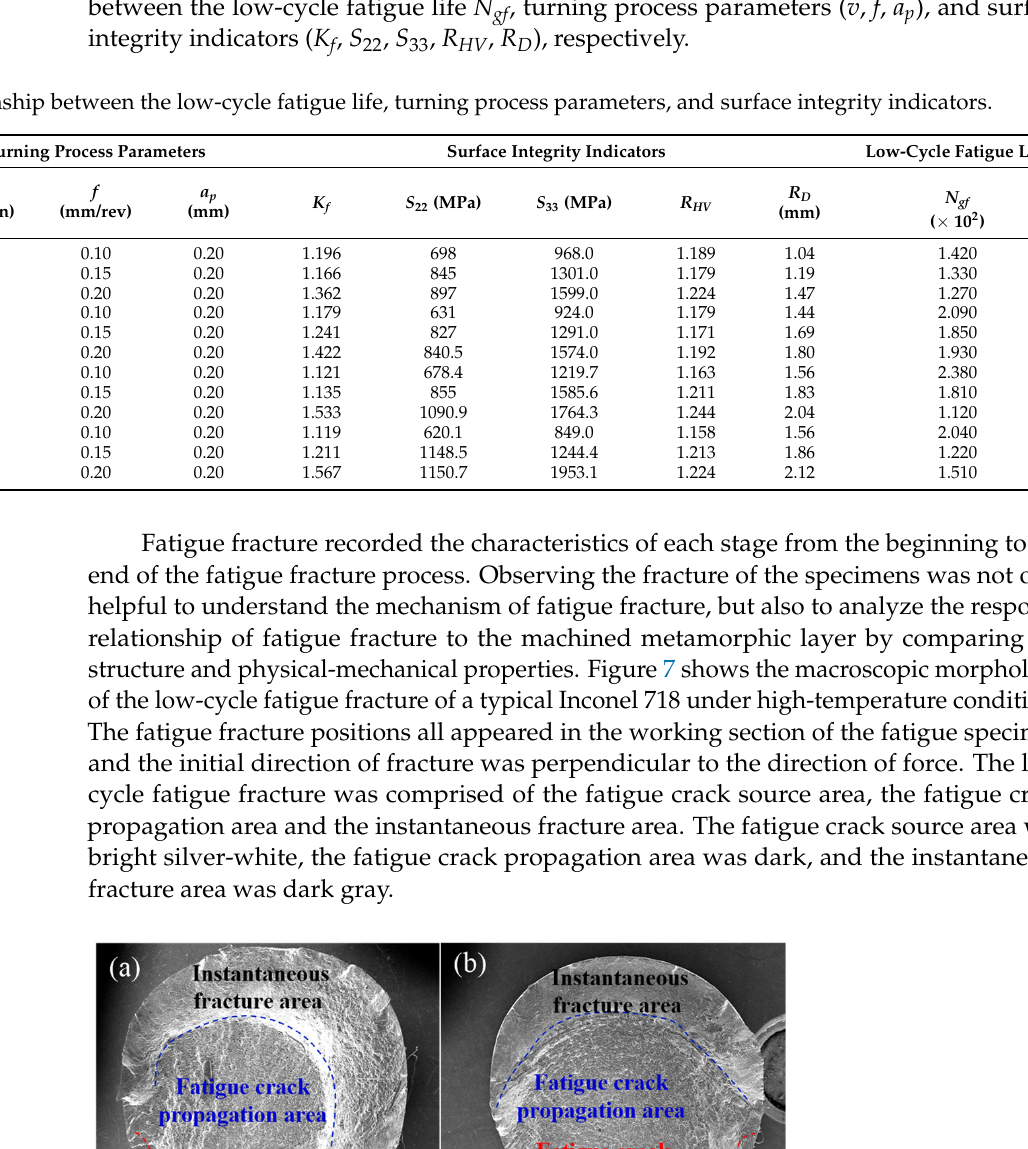
Table 1. Relationship between the low-cycle fatigue life, turning process parameters, and surface integrity indicators.